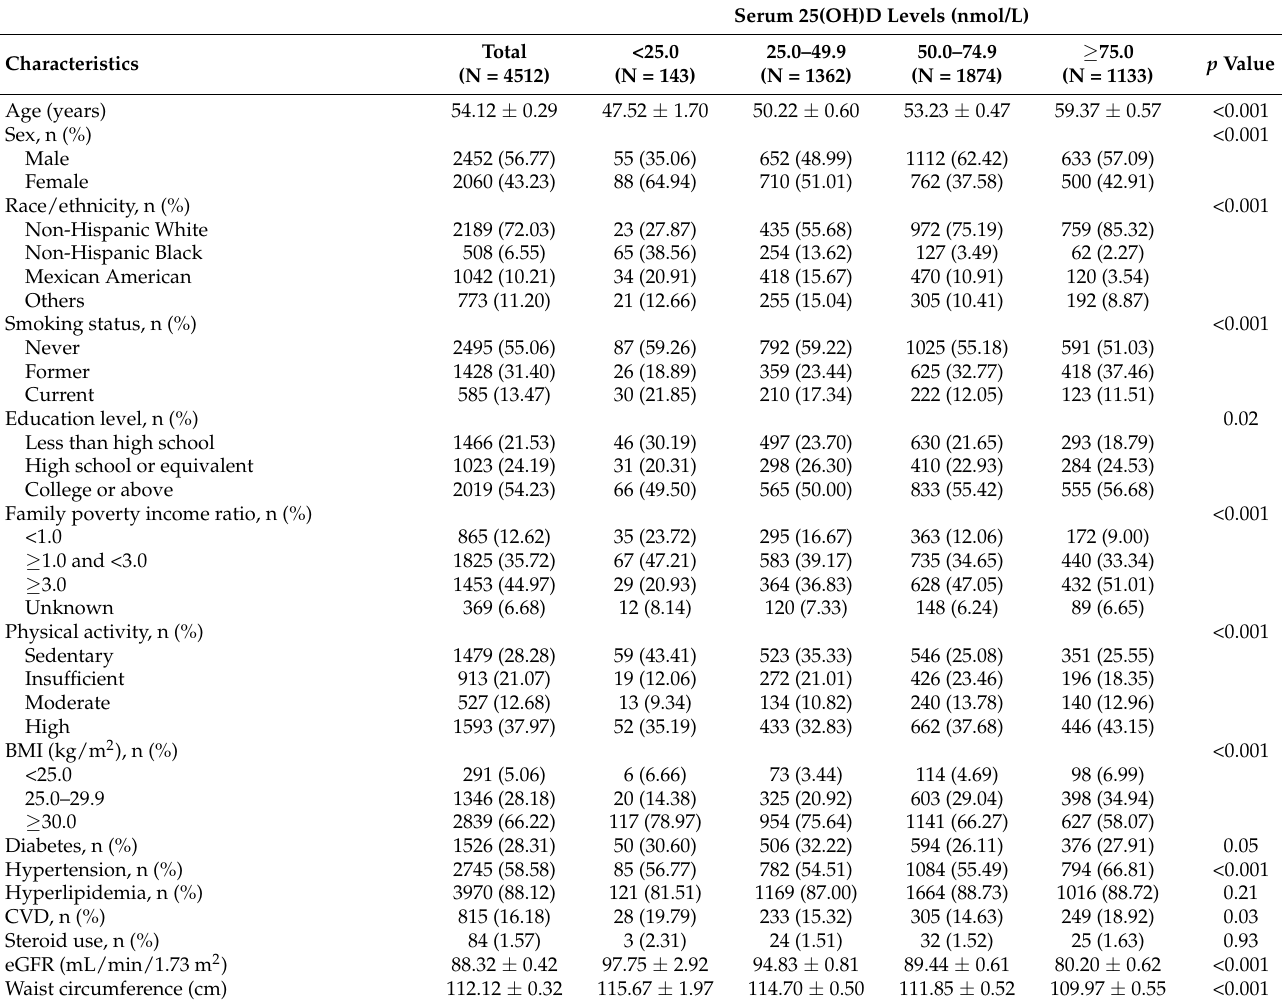
Table 1. Baseline characteristics of individuals with NAFLD based on serum 25(OH)D levels in NHANES,